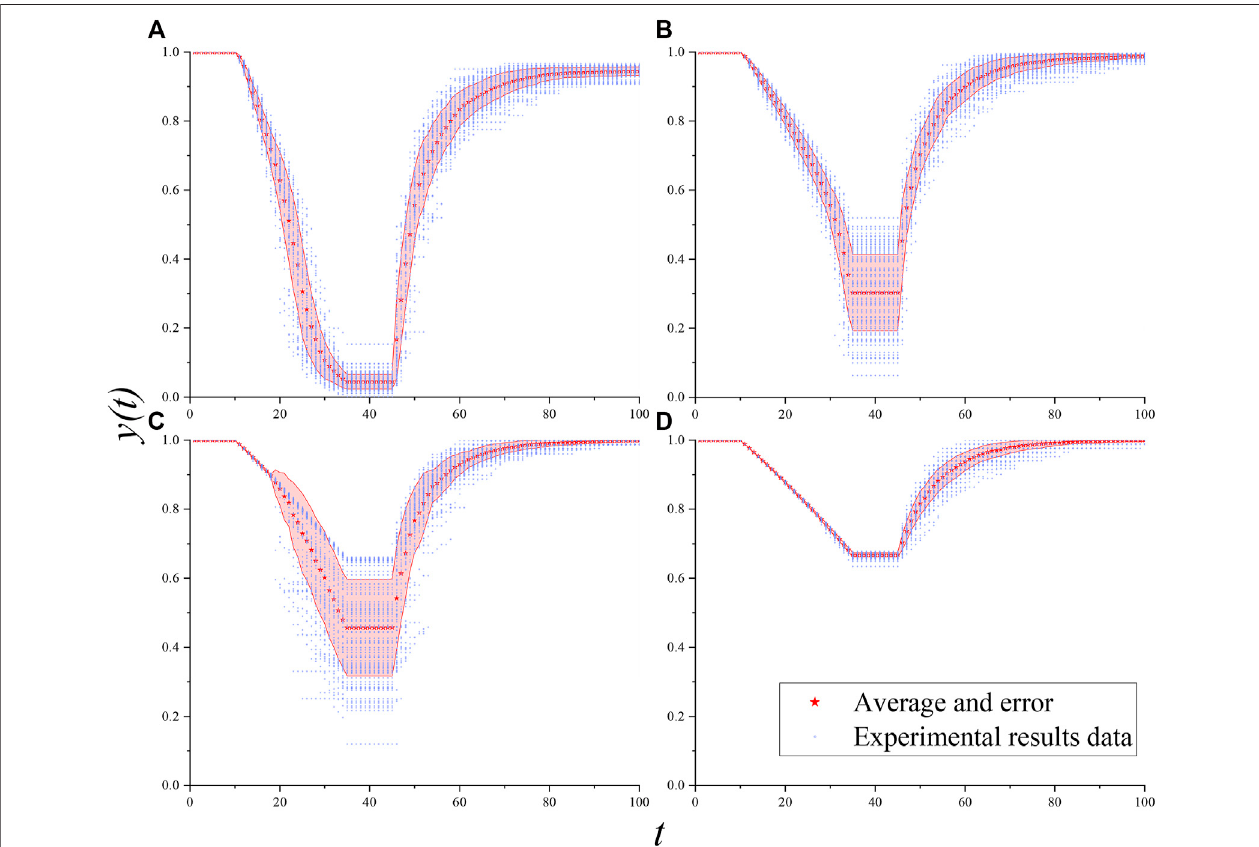
FIGURE 5 | Errors of UAV swarm resilience under different topologies. In the fi gure, the red pentagon is the mean of 100 experiments. The pink ribbon is the standard deviation of 100 experiments. The data for each experiment are the blue hollow tilted squares.